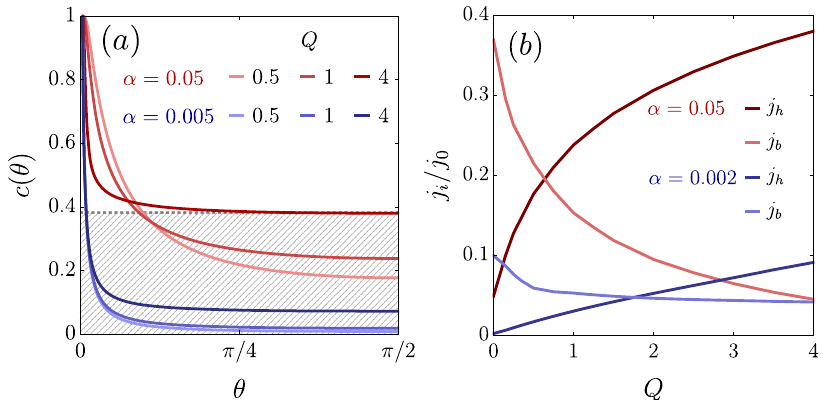
j b induced by the rest of the non-equilibrium distribution. b Comparison of the Fig. 3 | Normalized distribution function and currents in the two- fl uid picture. a The distribution function c ( θ ) in the para-hydrodynamic regime, for q =1, three para-hydrodynamic ( j h / j 0 ) and ballistic ( j b / j 0 ) current density contributions in the two- fl uid approximation for two values of α , where j 0 denotes the bulk current different values of Q and two α . With increasing Q , more weight is accumulated at density. For all α ≪ 1, the contribution of the para-hydrodynamic current increases thesteeptrajectoriesawayfrom θ =0.For α =0.05, Q =4,theasymptoticvalue c ( π / with Q , quickly overtaking the ballistic 2)= c 1 isindicatedbyagraydashedline.Inthetwo- fl uidapproximation,thecurrent j h stemmingfromtheareabelow c 1 (gray,hatched)iscomparedagainstthecurrent